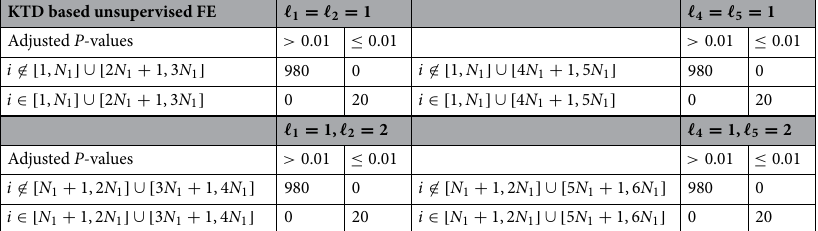
Table 11. Confusion matrices of selected is between true and those selected by KTD-based unsupervised FE applied to synthetic data set 2.